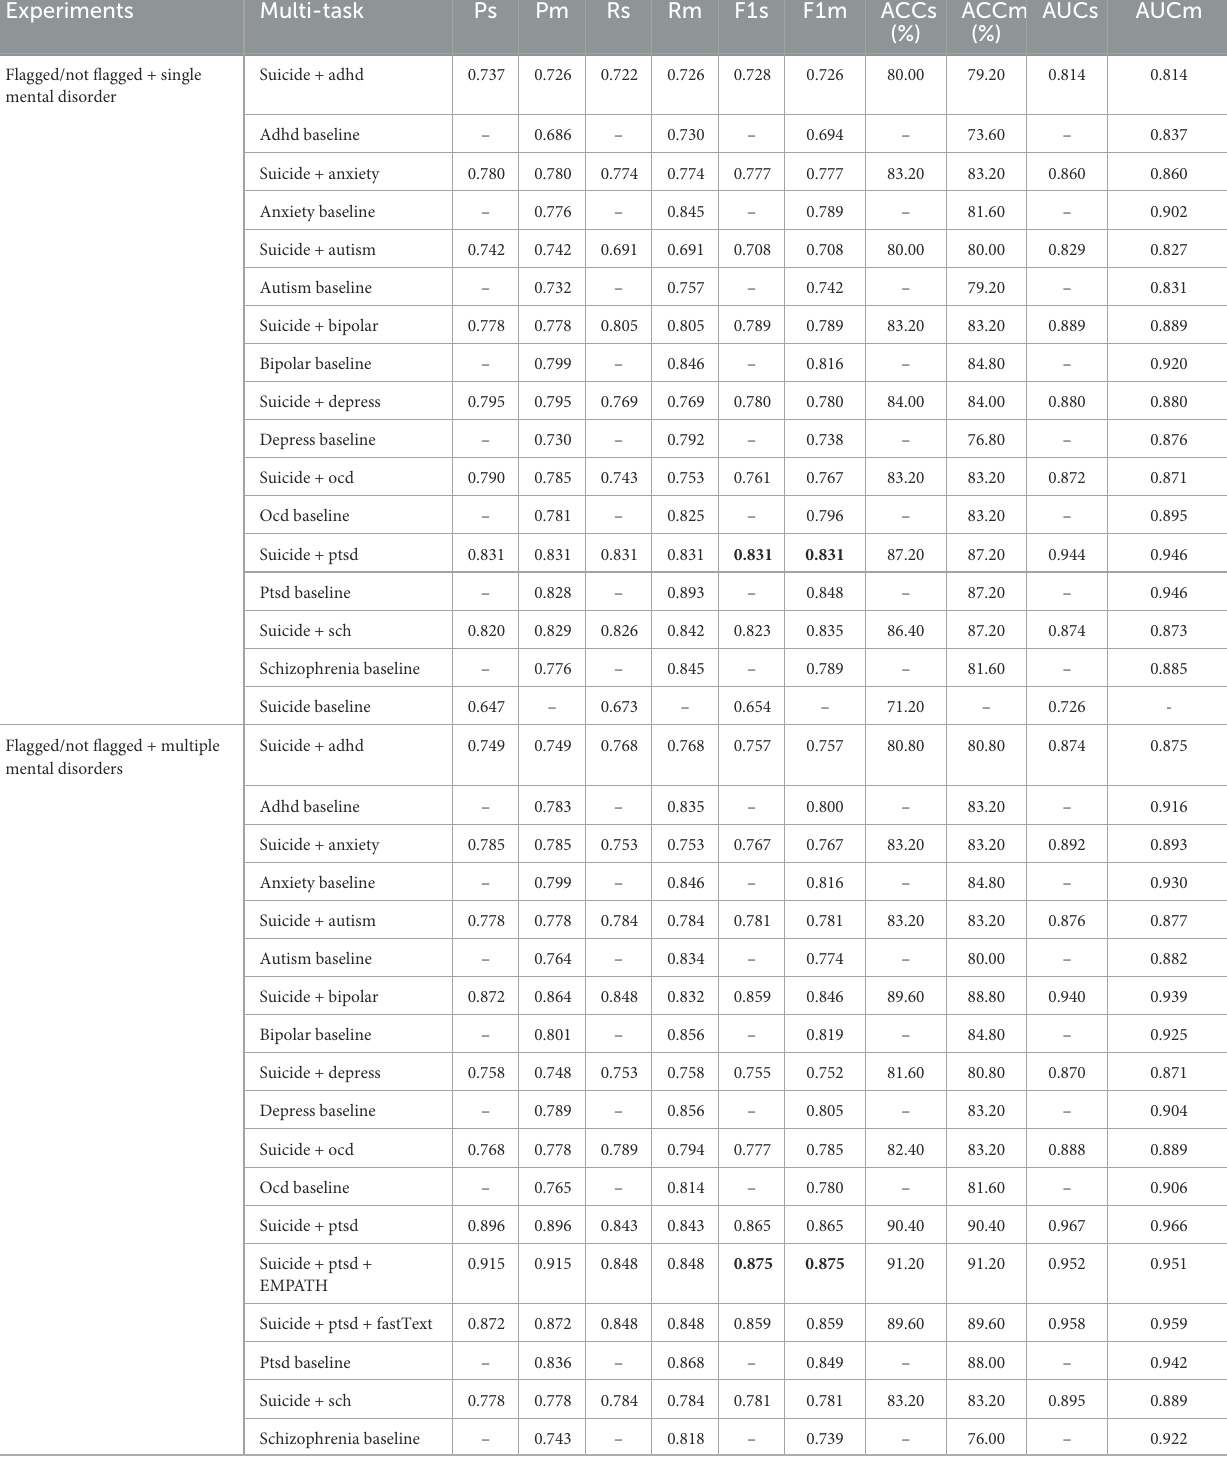
TABLE 7 Experiments: flagged/not flagged with users diagnosed with a single mental disorder (flagged/not flagged + single mental disorder), flagged/not flagged with users diagnosed with multiple mental disorders (flagged/not flagged + multiple mental disorders), flagged/not flagged with multiple mental disorders and evaluated on the expert annotated data, flagged/not flagged with users diagnosed with PTSD or depression (flagged/not flagged using tweets). Experiments